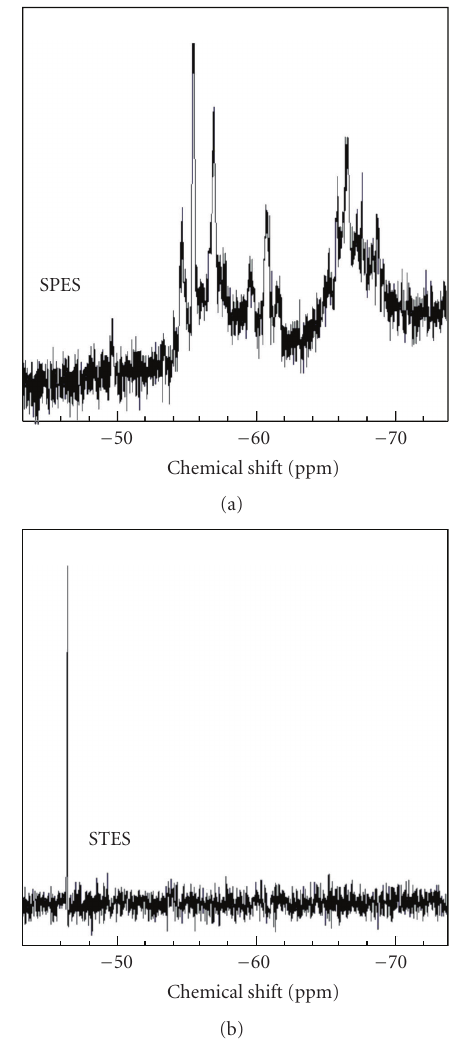
Figure 2: 29 Si NMR spectra of STES and SPES (number